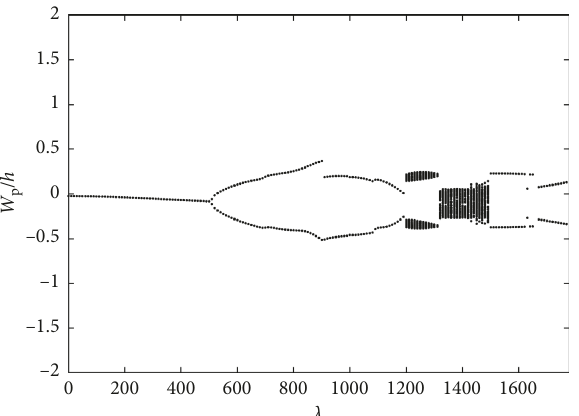
Figure 7: Bifurcation diagram versus dynamic pressure for H / h � 0 . 2 , Δ T / Δ T